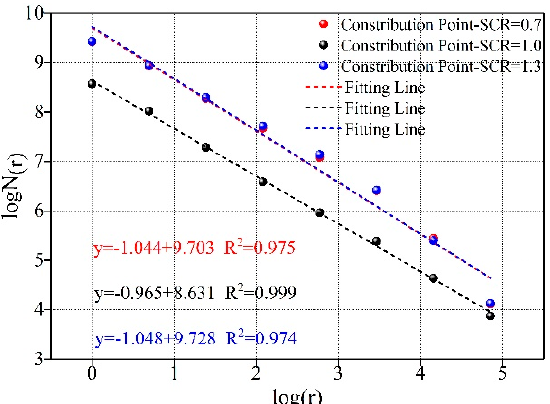
Figure 9. Calculation of fractal dimension under different SCR.